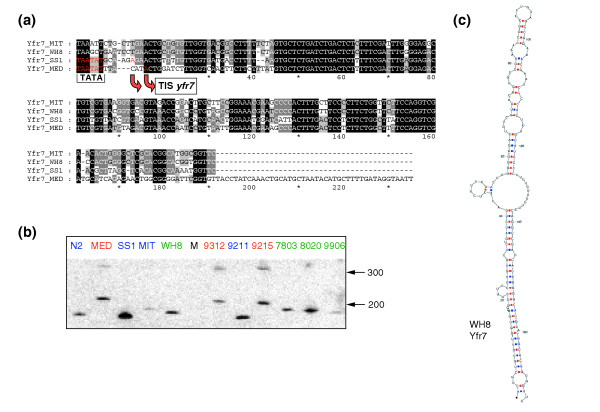
Characterization of Yfr7. (a) Sequence alignment of Yfr7 from four marine cyanobacteria. The 5' end transcriptional initiation site (TIS) was mapped for Yfr7 from MED4 and SS120. (b) In Northern blots, a signal for the predicted Yfr7 was detected with RNA from all four strains and seven additional strains from the marine cyanobacterial radiation: Prochlorococcus NATL2A (N2), MED4 (MED), SS120 (SS1), MIT 9313 (MIT), MIT 9312 (9312), MIT 9211 (9211), MIT 9215 (9215) and Synechococcus WH 8102 (WH8), WH 7803 (7803), WH 8020 (8020), RS9906 (9906). The high-light-adapted Prochlorococcus strains are labelled in red, low-light-adapted strains in blue, and Synechococcus strains are colour-coded in green; M indicates the marker lane. Numbers indicate lengths of RNA markers in nucleotides. (c) Prediction of secondary structure of the Synechococcus WH 8102 ncRNA Yfr7.